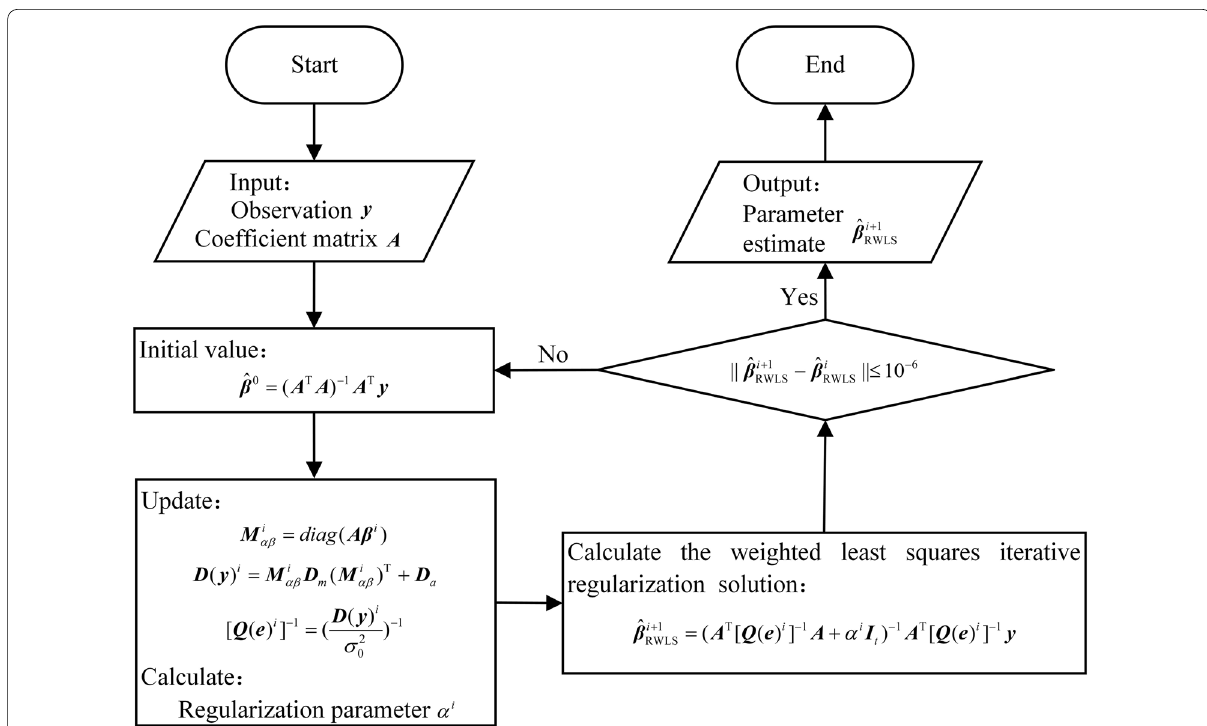
Fig. 2 Flowchart of the weighted least squares iterative solution for an ill-posed MAAMRE